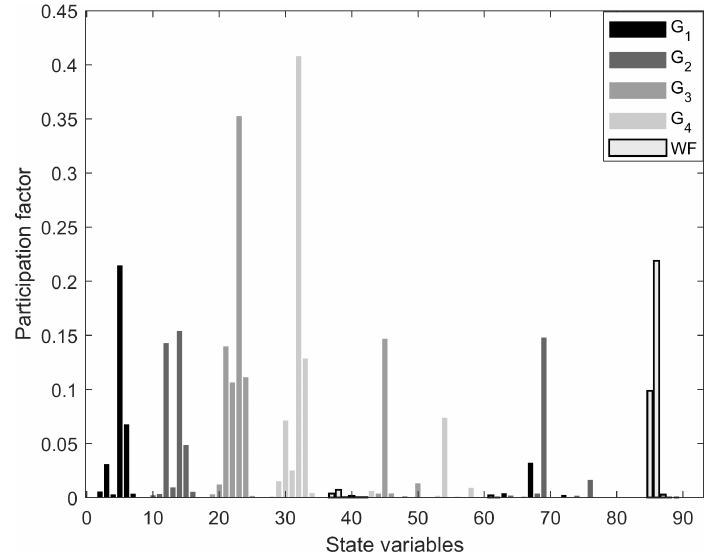
Figure 7. Participation factors associated with the inter-area mode λ ia ,3